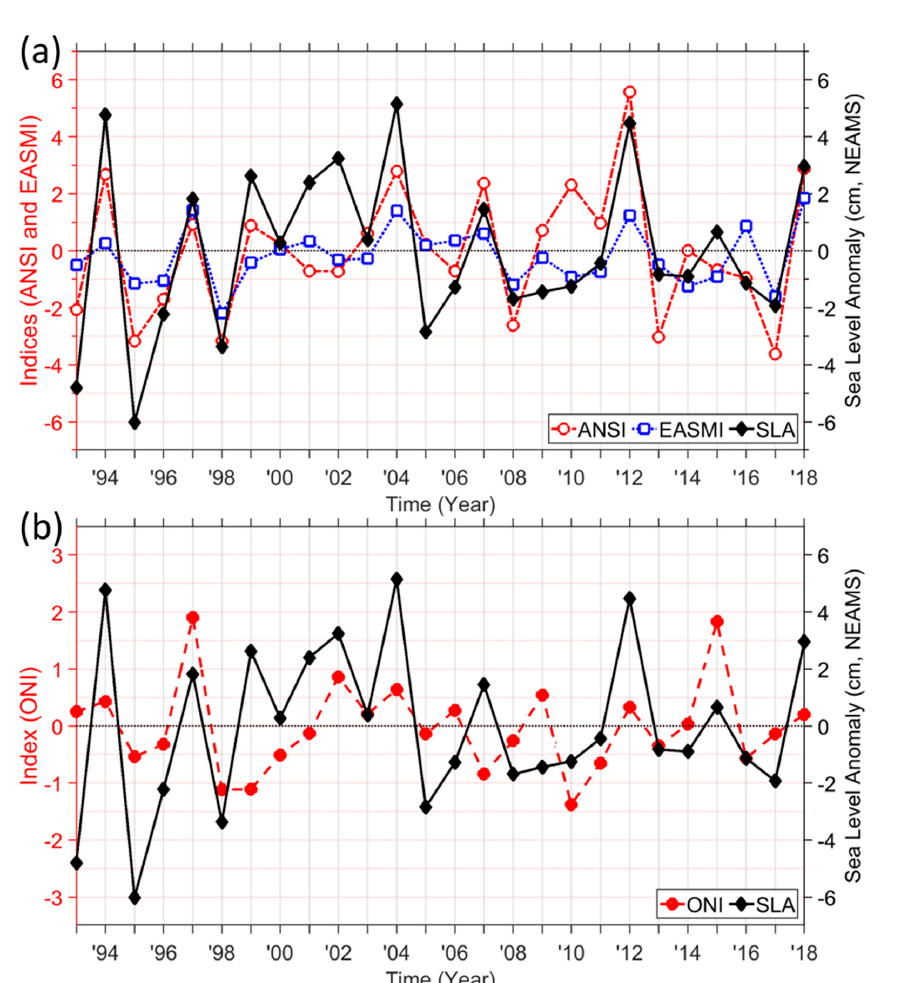
Figure 11. ( a ) Time-series of the ANSI (red dash-dotted line, left y-axis), the East Asian summer monsoon index (EASMI) (blue dotted line, left y-axis), and the ANSA (black solid line, right y-axis) in August from 1993 to 2018. The correlation coefficients between ANSA and ANSI, and ANSA and EASMI are 0.73 (p-value < 0.01) and 0.64 (p-value < 0.01), respectively. ( b ) Time-series of the Oceanic Niño Index (ONI) (red dashed line, left y-axis) and the ANSA (black solid line, right y-axis) and in August from 1993 to 2018. The correlation coefficient between ANSA and ONI is 0.35 (p-value < 0.09).